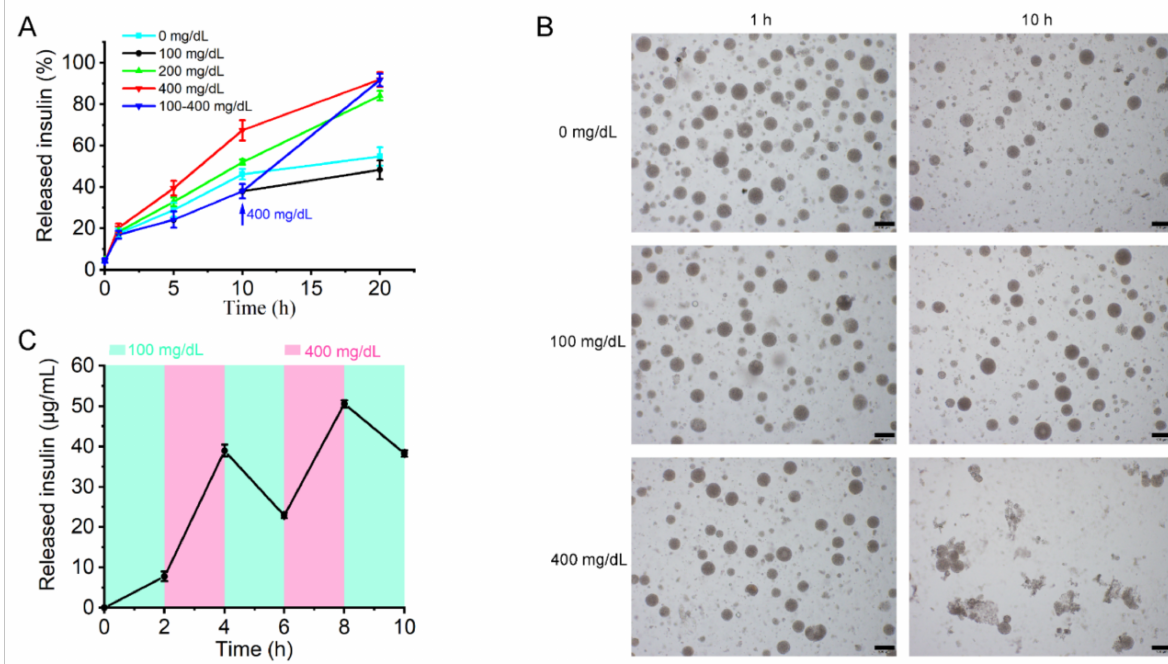
Figure 6. Insulin release of MVL(F+E+I) in vitro: ( A ) In vitro accumulated insulin release from MVL(F+E+I) in PBS (pH 7.4) with different glucose concentrations. Data are shown as mean ± SD ( n = 3). ( B ) Glucose concentration-dependent morphology changes in MVL(F+E+I) in PBS (pH 7.4) at 1 and 10 h. Scale bar = 100 µ m. ( C ) Pulsatile release profile of MVL(F+E+I) presents the rate of insulin release as a function of glucose concentrations. Data are shown as mean ± SD ( n =